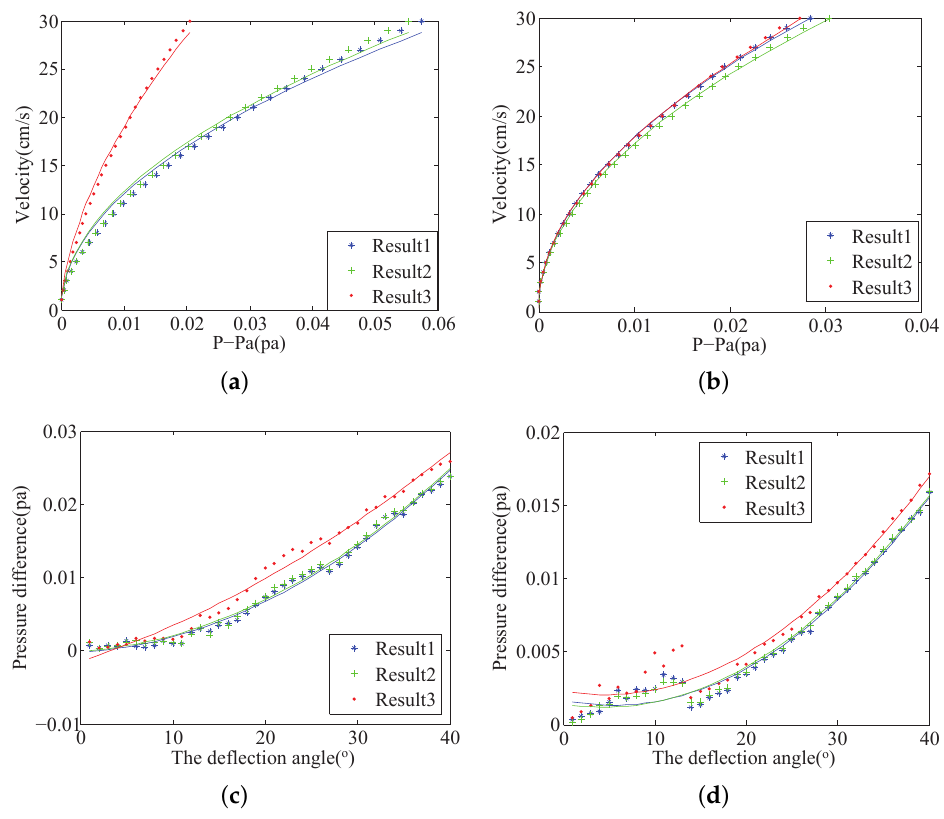
Figure 9. Experiment curves fitting in 4 conditions: ( a ) the UF Velocity condition , ( b ) the KVS Velocity condition, ( c ) the UF Angle condition, ( d ) the KVS Angle